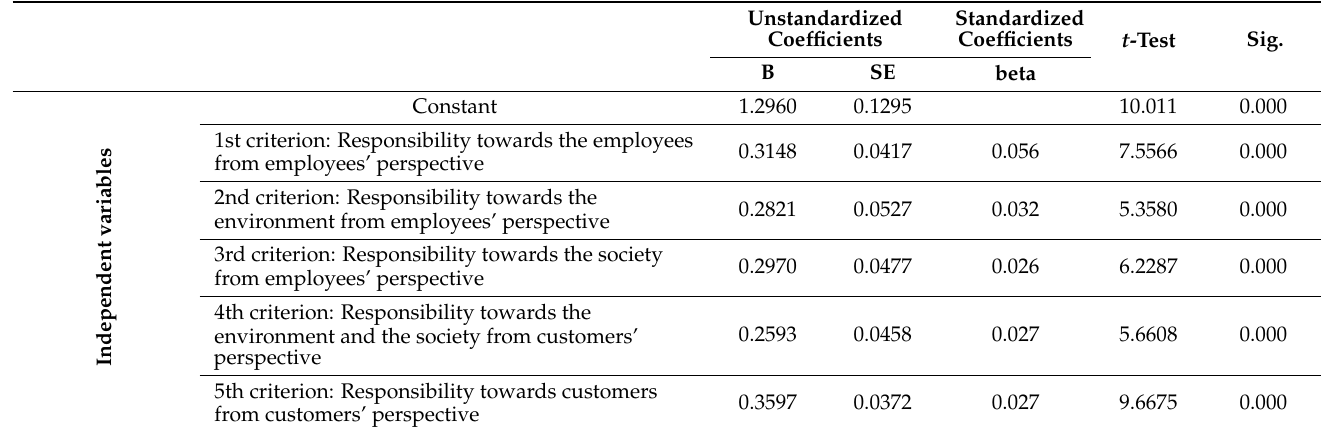
Table 6. Results of regression coefficients test of the study